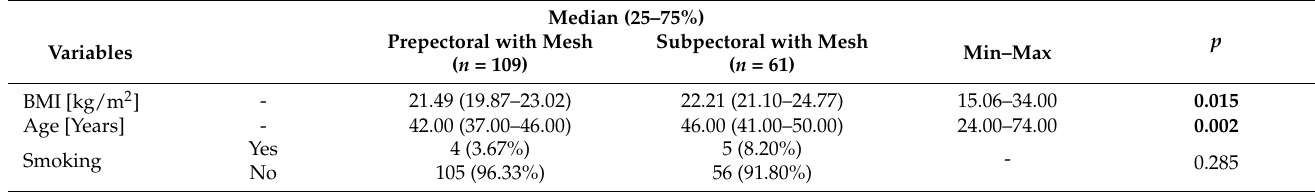
Table 1. Demographic characteristics of individual patients participating in the study. Median (25–75%)